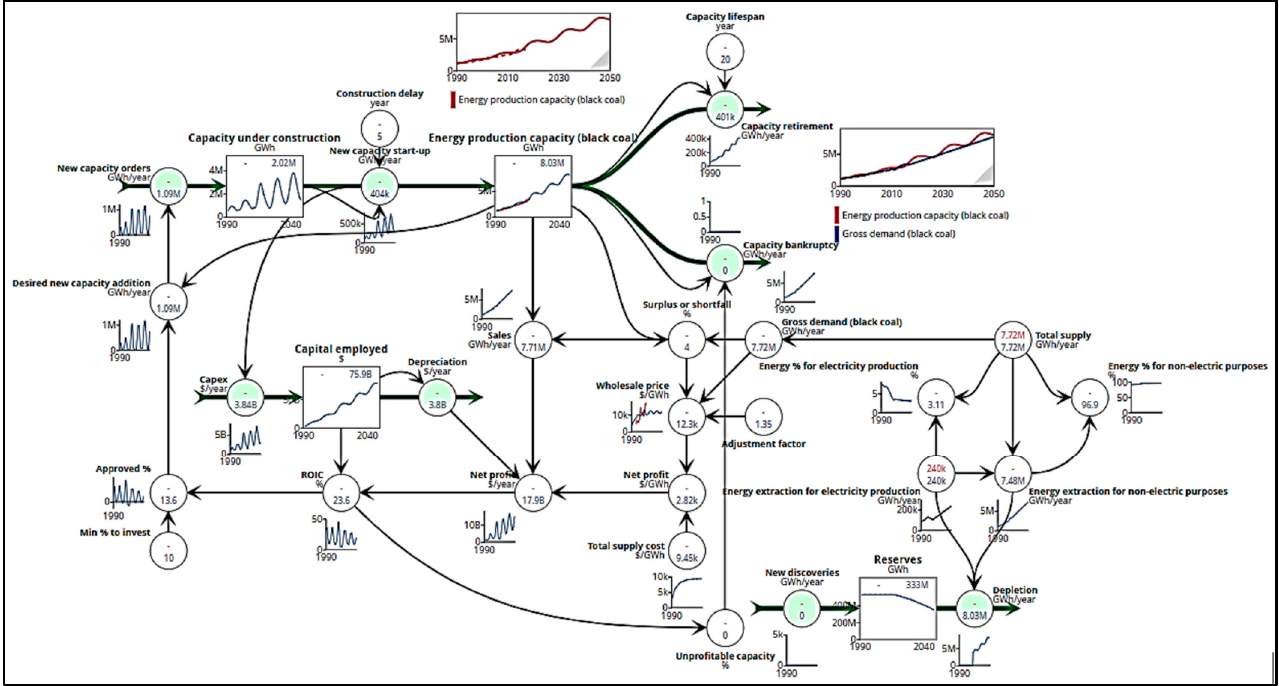
Figure 3. The energy sources extraction pipeline.